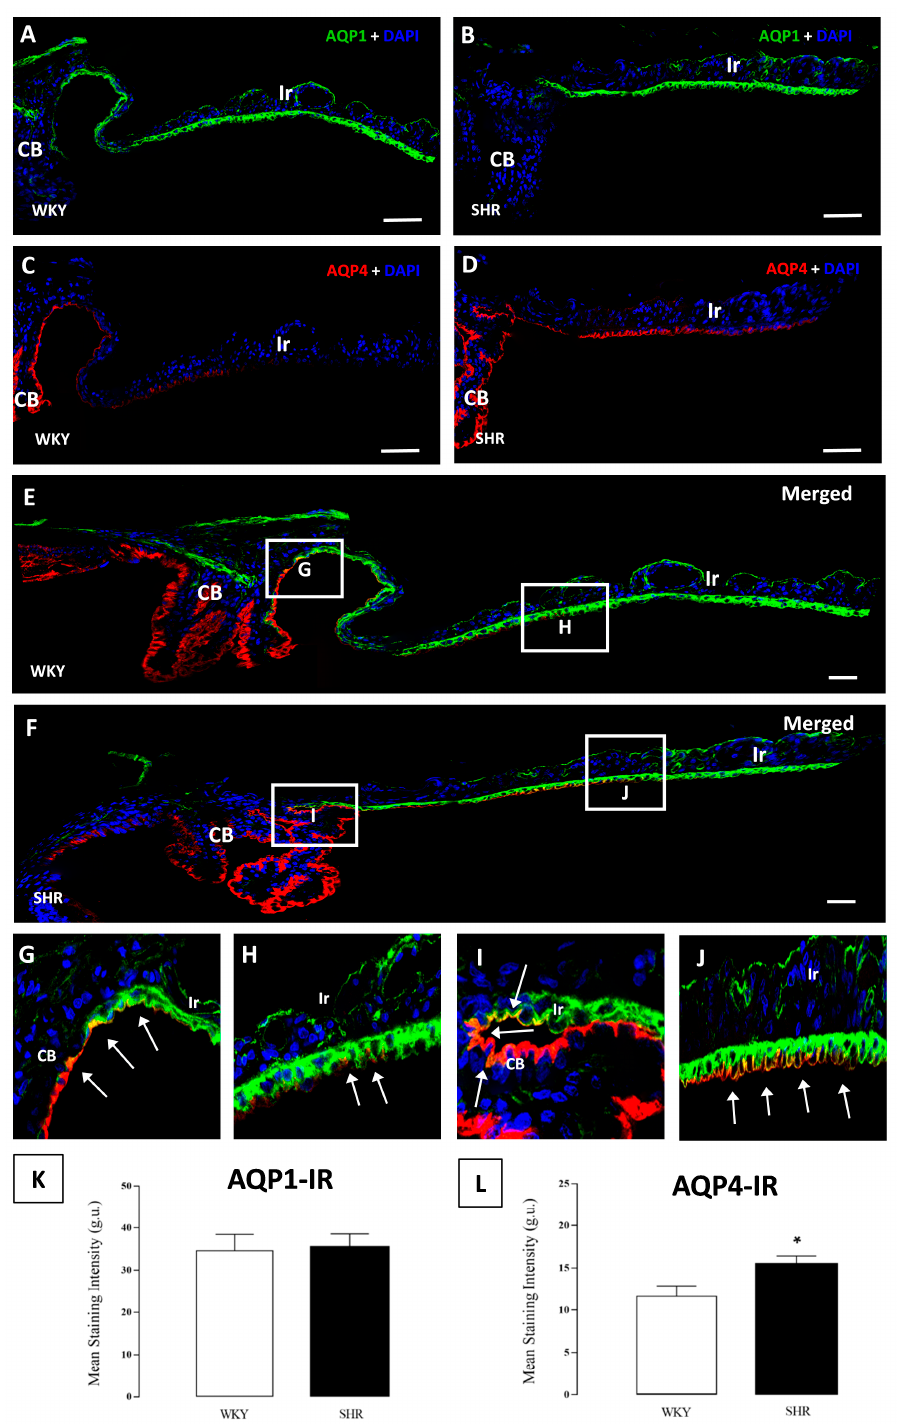
Figure 4. Confocal microscopy images of the expression of AQP1 and AQP4 in the iris of WKY ( E ) and SHR ( F ) rats. No differences were found in the iris AQP1 staining between WKY and SHR rats ( A , B ). A reduction in AQP4 expression was observed in the epithelium, which went towards the pupillary rim, and was higher in WKY rats ( C , D ). Images ( G , I ) represent the co-localization of AQP1 and APQ4 in the transition zone between the CB and iris, while ( H , J ) represent the co-localization in the iris. At the bottom, values of stain intensities in r.u. for AQP1 ( K ) and AQP4 ( L ) are represented as the means ± SD ( n = ten animals per group) * p < 0.05 WKY vs. SHR rats. Ir: iris; CB: ciliary body. Scale bars 40 μ m.